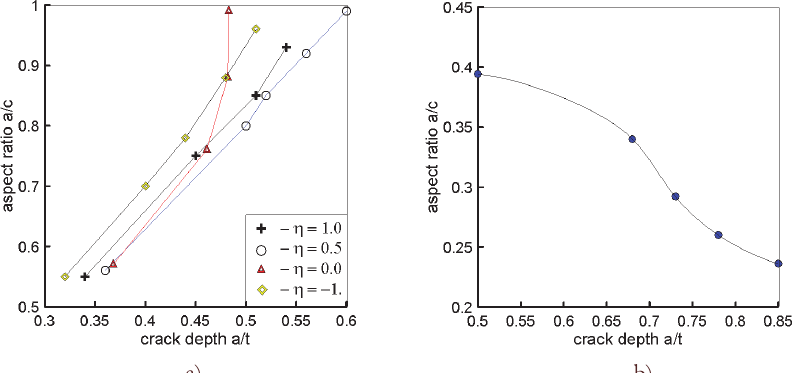
Figure 4: Aspect ratio versus crack depth under (a) different biaxial loading and (b)